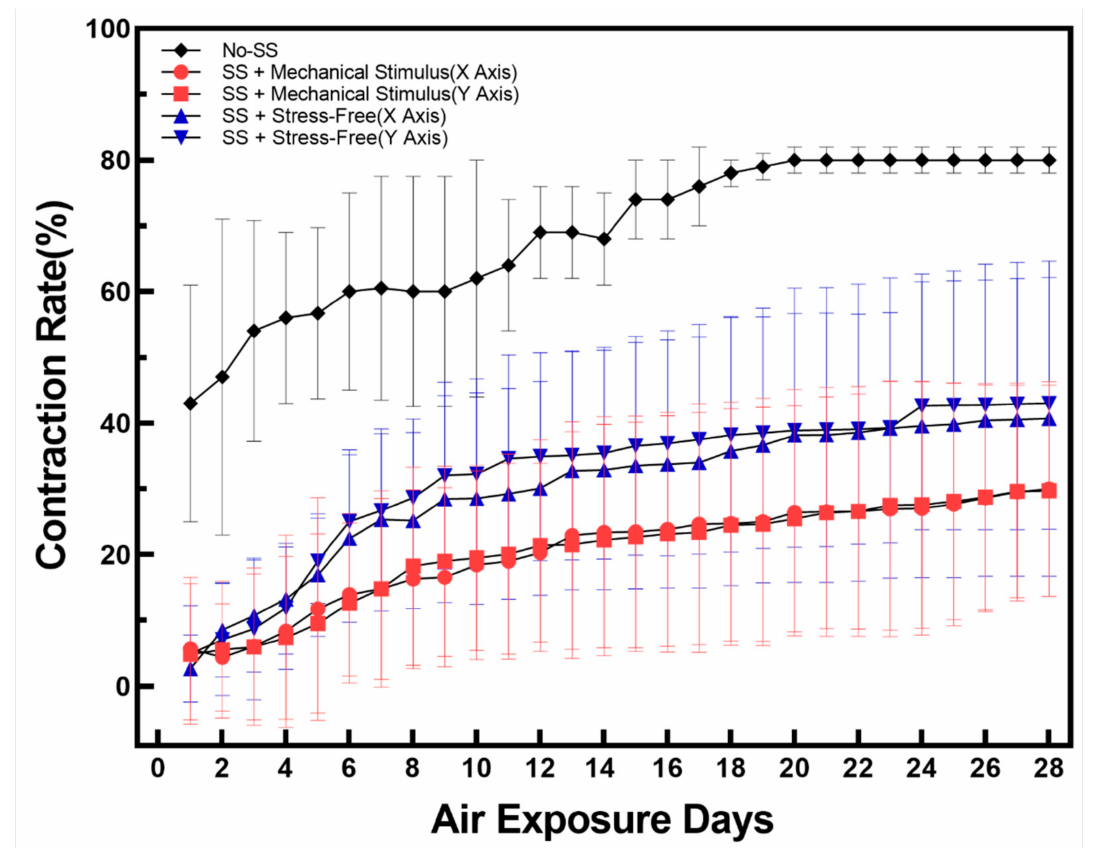
Figure 1. Variations of tissue contraction rate during 28 days of air exposure for three types of samples: No-SS means no sulfo-SANPAH treatment and no mechanical stimulus; SS + Mechanical Stimulus ( X Axis) means sulfo-SANPAH treatment sample applied by along compressive stimuli direction; SS + Mechanical Stimulus ( Y Axis) means sulfo-SANPAH treatment sample applied by along compressive stimuli direction; SS + Stress-free ( X , Y Axis) means sulfo-SANPAH treatment sample without compressive stimuli. For each condition, the tissue contraction was calculated from eight chips and the average value was displayed. Error bars indicate standard error of the